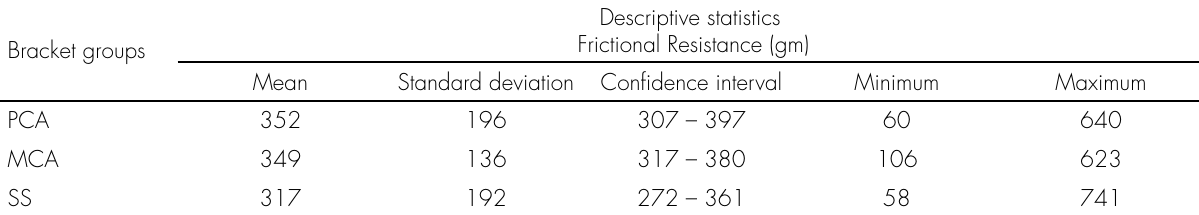
Figure 3. Bar graph of the comparison between mean values of frictional resistance among Table III. Descriptive statistics of the overall frictional resistance among brackets groups (wet environment). (PCA) polycrystalline alumina. (MCA) monocrystalline alumina. (SS) Stainless bracket types in all three wire angulations (dry environment). (PCA) polycrystalline alumina brackets. (MCA) monocrystalline ceramic brackets. (SS) stainless steel brackets. *** p<0.001 Bracket groups